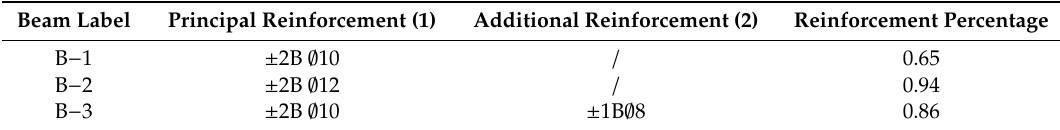
Table 5. The reinforcement data for the tested beams.